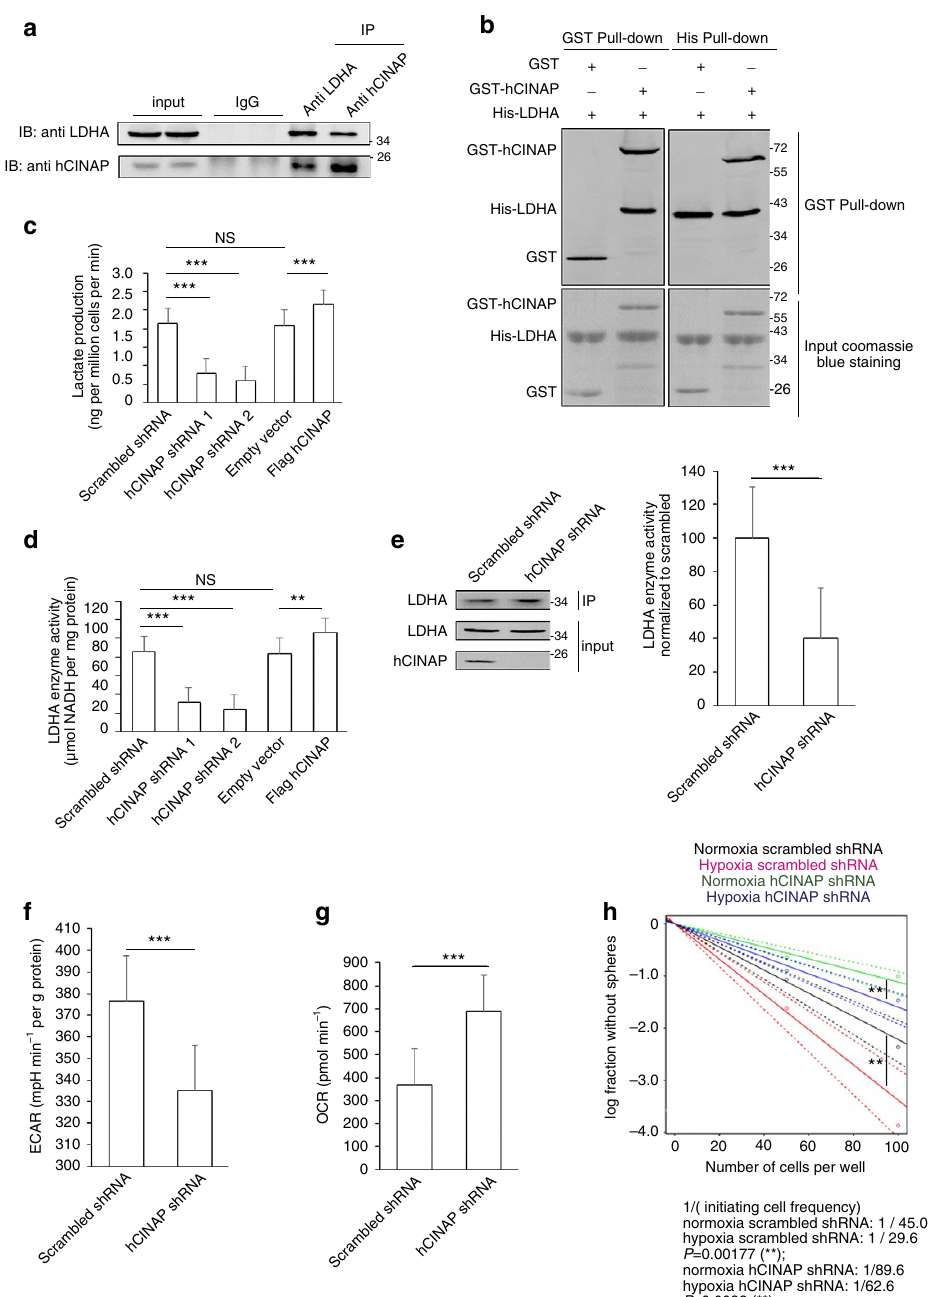
Figure 3 | hCINAP directly binds to LDHA and promotes LDHA activity. ( a ) Immunoprecipitation analysis of the interaction between endogenous hCINAP and LDHA protein in SW480 cells. Rabbit IgG served as a negative control. See also the hCINAP-interacting partners screening in Supplementary Fig. 2. ( b ) In vitro pull-down analysis of the interaction between GST-tagged hCINAP and His-tagged LDHA protein purified from E. coli , with GSTprotein as a negative control. See also the details within the FGFR1–LDHA–hCINAP interaction in Supplementary Fig. 3. ( c ) Lactate production levels in SW480 cells transfected with the indicated shRNAs and plasmids were determined by a spectrophotometer and normalized to the cell number. ( d ) LDHA enzyme activity was determined in SW480 cellls as indicated. ( e ) Endogenous LDHA protein was immunoprecipitated and subjected to enzymatic activity assay. Western blot analysis showed immunoprecipitated LDHA protein in lysates of SW480 cells treated with control shRNA and hCINAP shRNA 2. The experiments were performed three times. ( f , g ) Measurements of ECAR and OCR levels of SW480 cells in e . ( h ) Limiting dilution assay in CRCSCs as indicated under normaxia or hypoxia (3% O 2 ). CRCSC frequency is calculated by extreme limiting dilution analysis. ** P o 0.01. Also see LDHA Y10 phosphorylation and LDHA activity in Supplementary Fig. 6a,b. Data in c – g are determined by Student’s t -test and presented as mean ± s.e.m. ( n ¼ 3). ** P o 0.01, *** P o 0.001, NS, not significant. NATURE COMMUNICATIONS|8:15308|DOI: